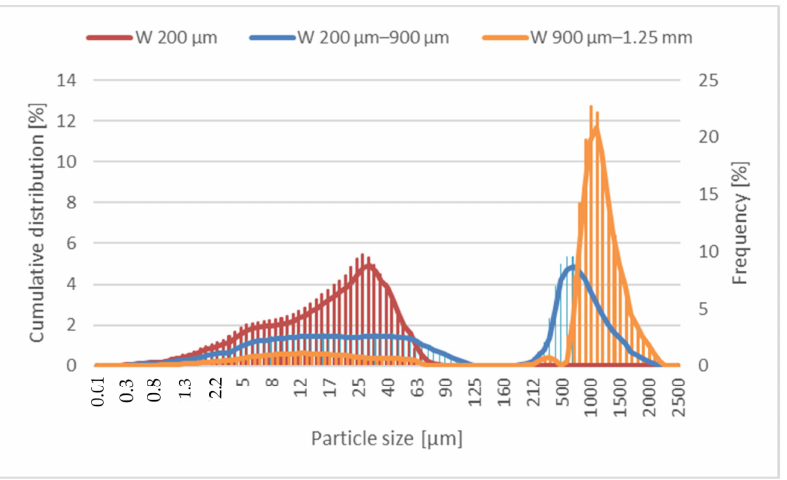
Figure 1. Diagram of particle distribution of W 200 µ m, W 200–900 µ m and W 900 µ m–1.25 mm. Table 2. Composition of the prepared geopolymers.